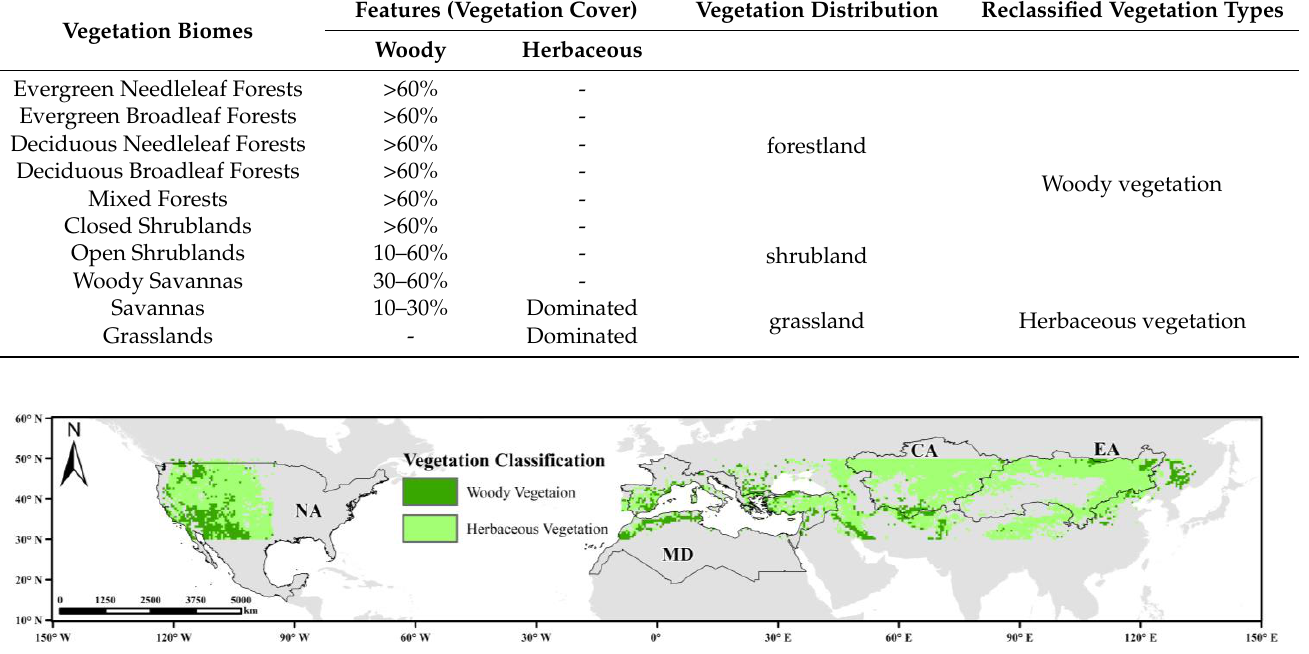
Figure A1. Distributions of herbaceous and woody vegetation.